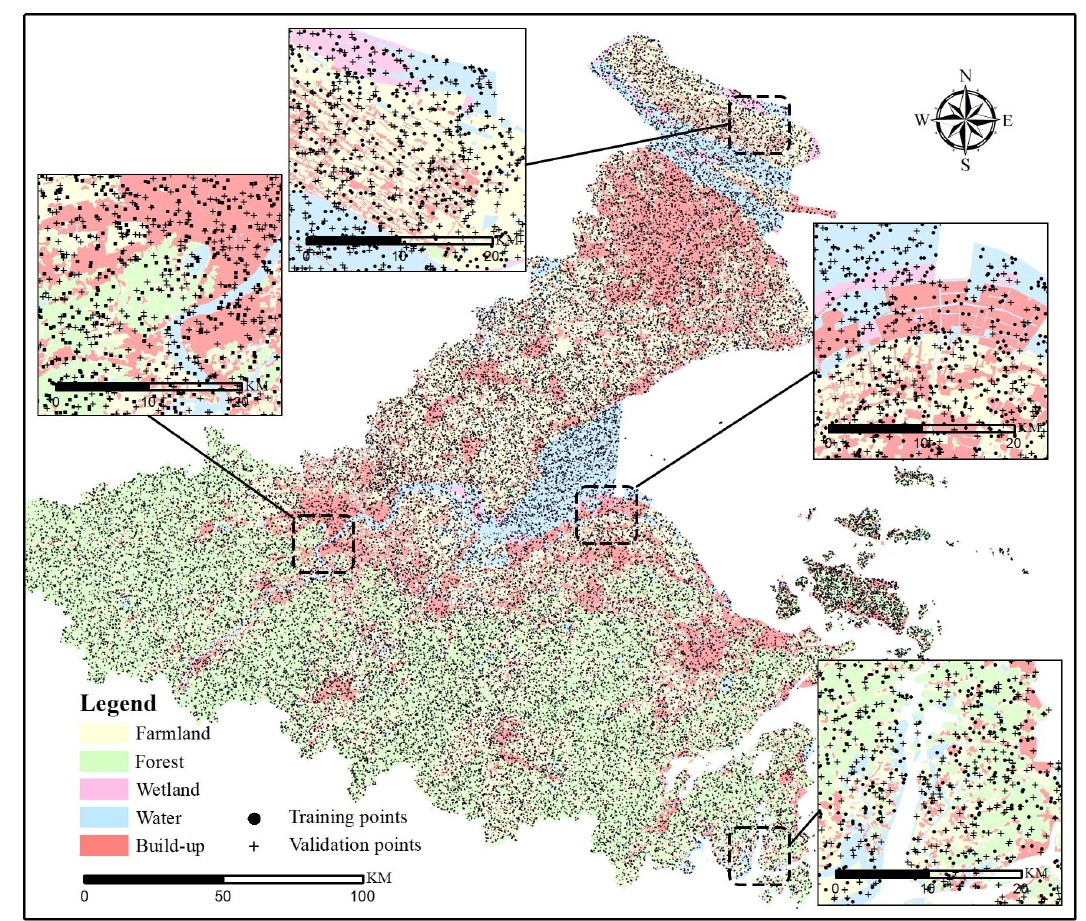
Figure 4. Distribution of the random points for training and validating the land use classification of 2020. The dots represent the training points, and the crosses represent the validation points; the Globeland30 data of 2020 is presented as the background.